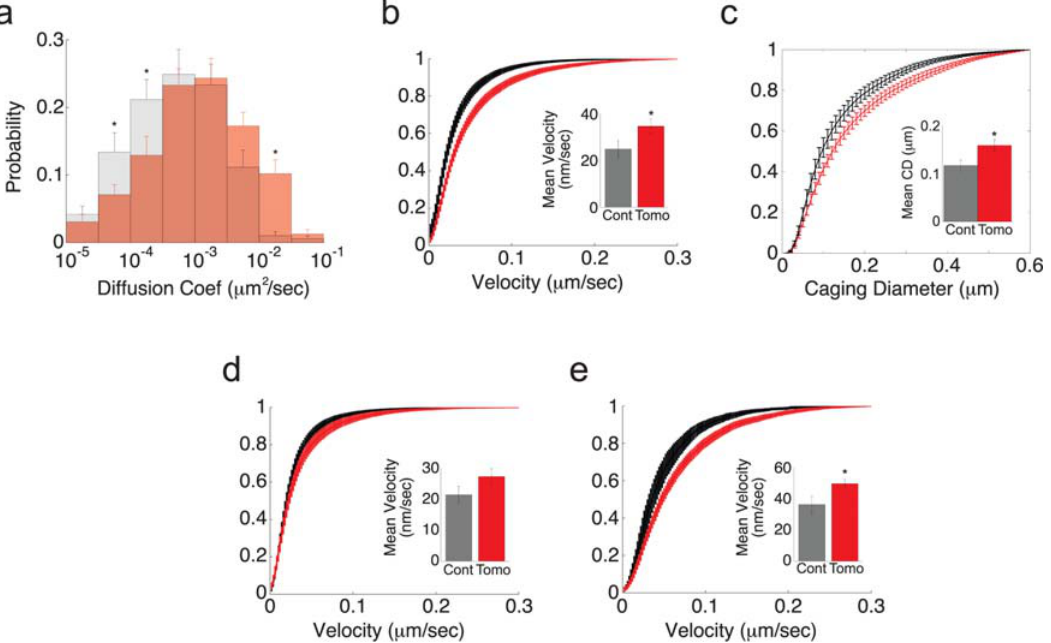
Figure 4. Tomosyn increases the mobility of newcomer vesicles. (a) . Logarithmically binned histogram of diffusion coefficients averaged across cells in control (gray) and tomosyn-overexpressing (red) cells. (b) . Average mobility cumulative distribution function (cdf) of control (black) and tomosyn-overexpressing (red) cells. Inset shows the mean velocity calculated for control (24.8 6 3.6 nm s 2 1 ) and tomosyn-overexpressing cells (34.5 6 3.1 nm s 2 1 ). (c) . Average cumulative histogram of the caging diameter (CD) of vesicles in control (black) and tomosyn-overexpressing (red) cells. Inset shows the mean CD for tomosyn-overexpressing cells (134 6 10.3 nm) and controls (112 6 9.5 nm). (d) . Average mobility cdf of resident vesicles in control (black) and tomosyn-overexpressing (red) cells. Inset shows the mean velocity of resident vesicles in control (21.2 6 2.6 nm s 2 1 ) and tomosyn-overexpressing cells (27.1 6 2.4 nm s 2 1 ). (e) . Average ptpv cdf of newcomer vesicles in control (black) and tomosyn-overexpressing (red) cells. Inset shows the mean velocity of newcomer vesicles in control (36.1 6 5.4 nm s 2 1 ) and tomosyn-overexpressing cells (49.5 6 3.0 nm s 2 1 ). All